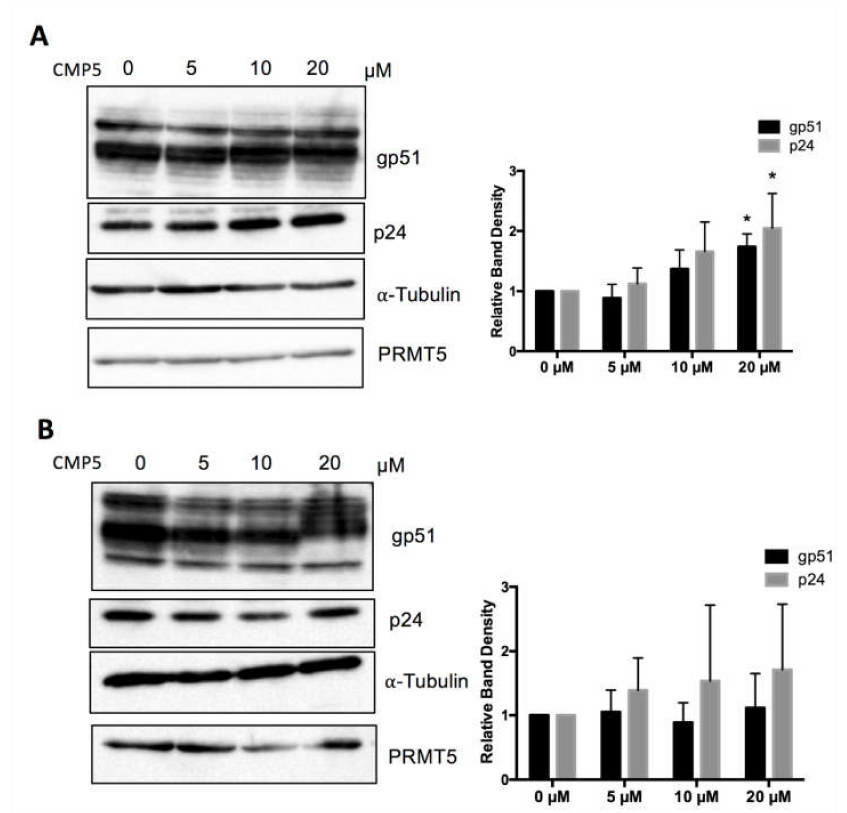
Figure 6. E ff ect of a small molecular PRMT5 inhibitor (CMP5) on BLV protein expression. FLK-BLV ( A ) or PK15-BLV ( B ) were cultured in the absence or the presence of the indicated concentrations of CMP5 for 48 h. Cell lysates were prepared and viral proteins (Env gp51 and Gag p24) in addition to PRMT5 were evaluated by Western blotting. The relative band density of each protein normalized to α -tubulin expression is shown for each cell line. The PRMT5 expression level was not changed as a result of CMP5 treatment and was excluded from analysis. All band layers of gp51 were calculated. Error bars represent the standard deviation of three independent experiments. The p value was calculated using the Student’s t -test. The asterisk indicates a significant di ff erence (* p ≤ 0.05). Positions of BLV gp51 and p24, PRMT5, and α -tubulin proteins are